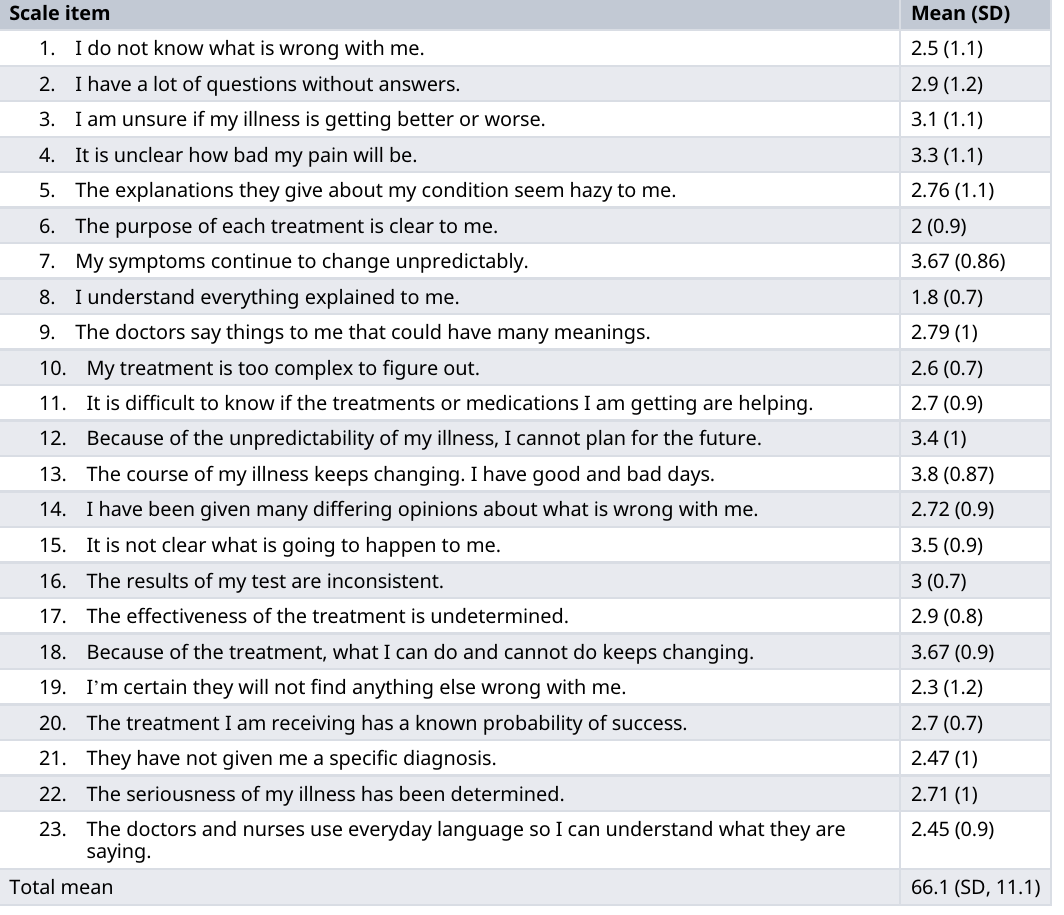
Table 3. Description of Mean Uncertainty Score (MUIS-C) (N = 153). Scale item